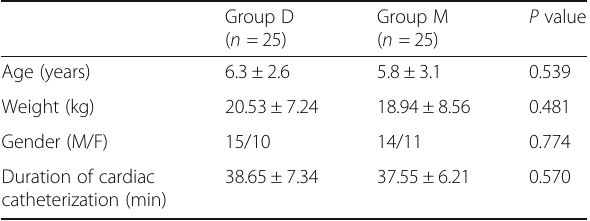
Table 3 Demographic patients ’ characteristics and procedure duration (data are presented as mean ± SD or ratio) Group D ( n =